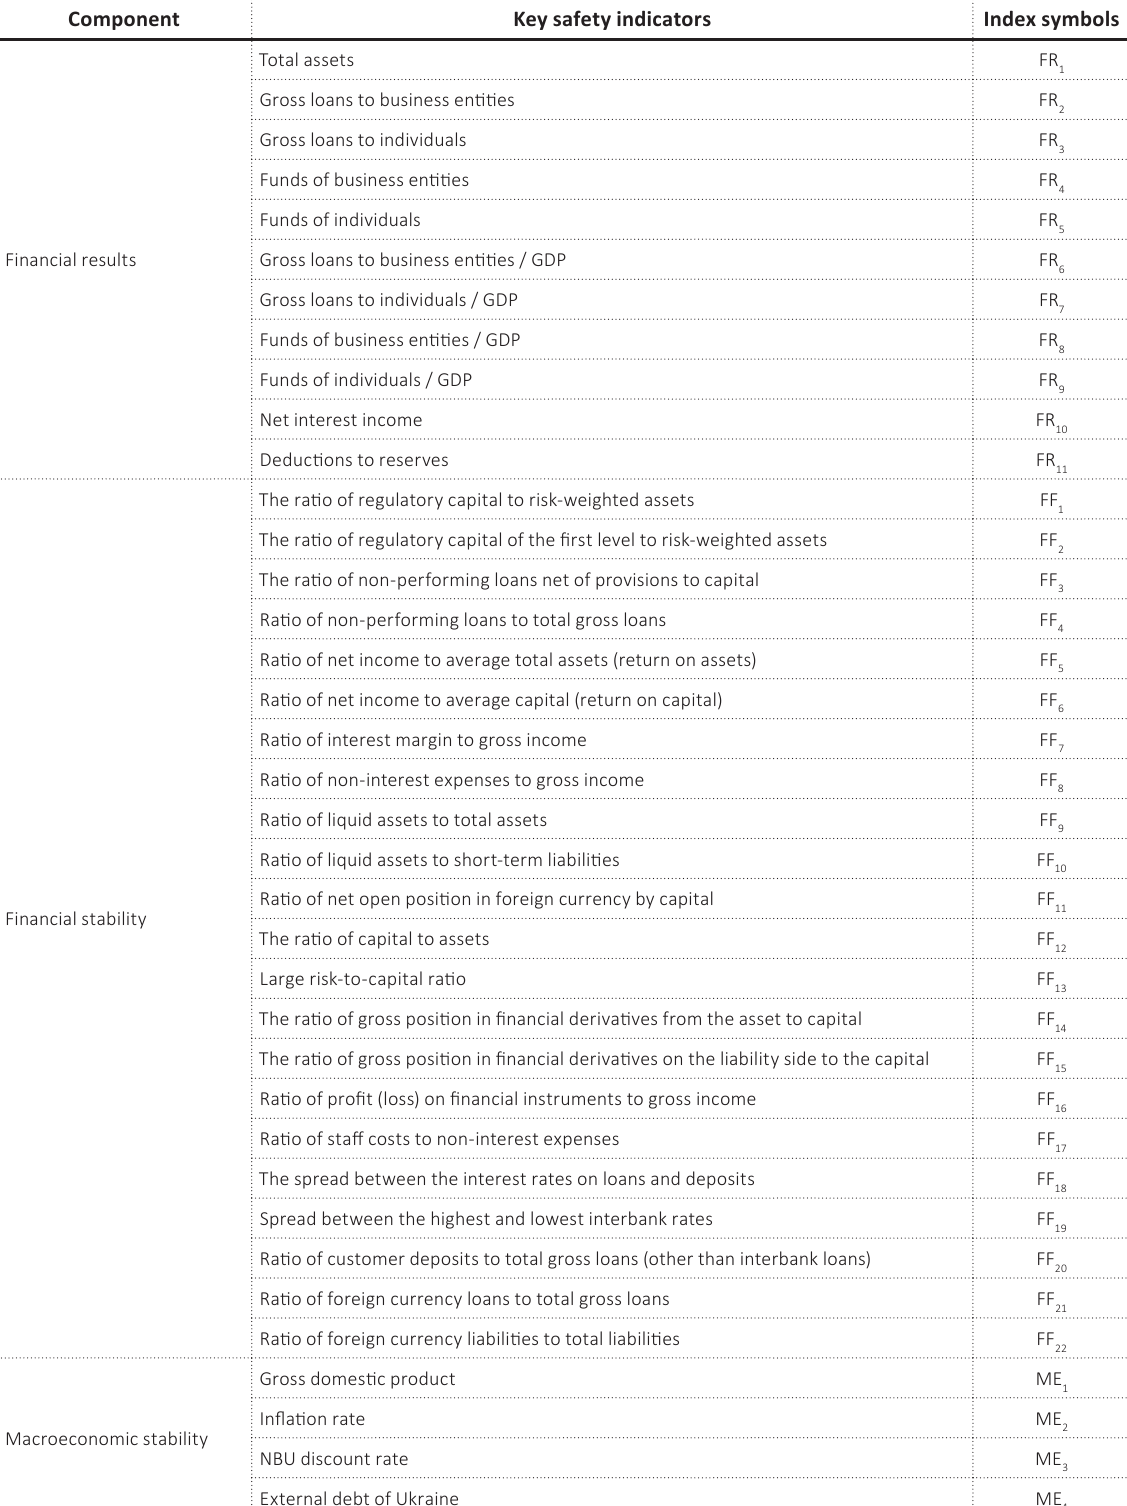
Table A1. System of indicators for evaluating the Ukrainian banking sector’s financial security Source: Grouped and supplemented according to Karkovska et al. (2018), Snishchenko (2018), Subbotovych et al. (2013), Zachosova et al. (2018), Overview of the banking sector by NBU